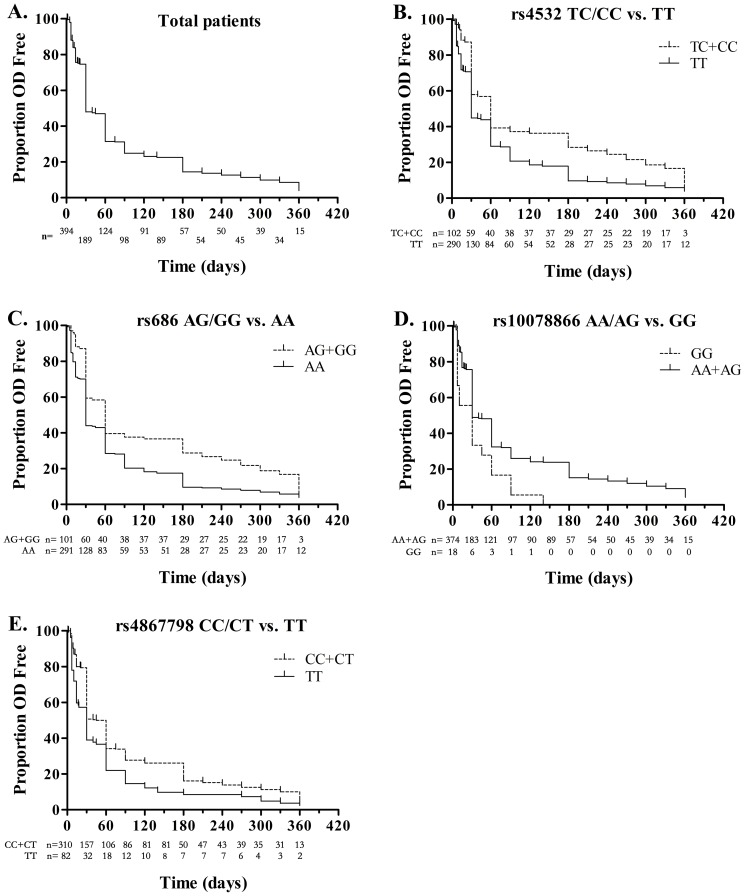
Kaplan–Meier survival curves representing probability that individuals have not experienced dependence over the period of time following first opioid use.Total addicts (A), stratified by combined minor allele homozygote and heterozygote vs. major allele of rs4532 homozygote (B), by combined minor allele homozygote and heterozygote vs. major allele of rs686 homozygote (C), by combined major allele homozygote and heterozygote vs. minor allele of rs10078866 homozygote (D), by combined major allele homozygote and heterozygote vs. minor allele of rs4867798 homozygote (E). The numbers of patients who have not experienced dependence at a certain time are shown below x-axis for each genotype.